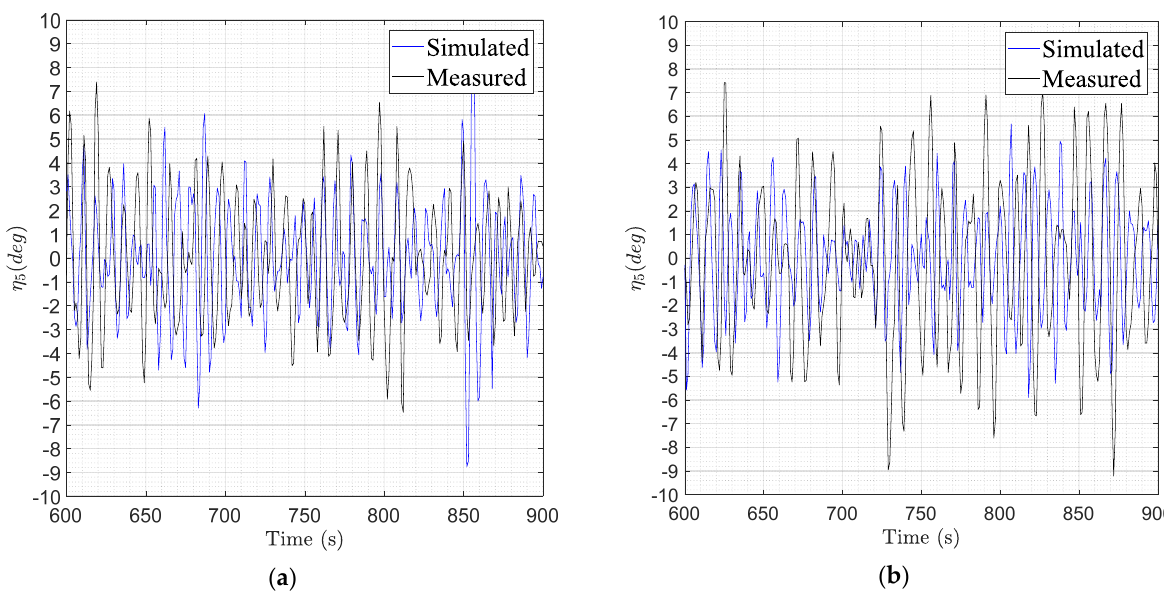
Figure 9. Pitch time series comparison: ( a ) 7 January 2020; ( b ) 8 January 2020.